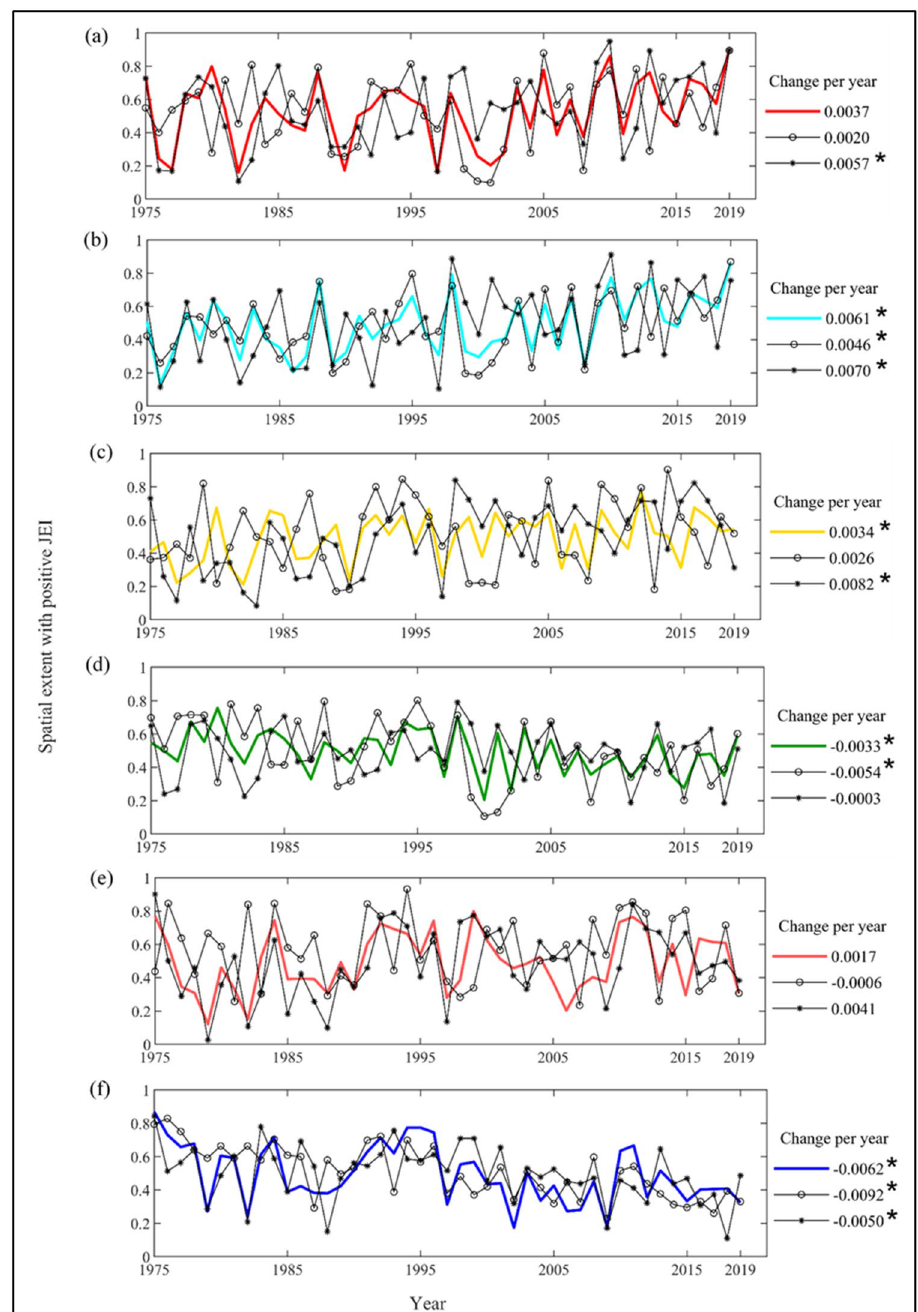
Figure 3. Year-wise variation of areal coverage (in proportion of entire Indian mainland) exhibiting positive Joint Extreme Indices (JEIs) during the post-climate regime shift period, i.e. 1975–2019 for three cases considering entire year (shown in solid shaded lines), monsoon season (shown in black lines with circle markers) and non-monsoon season (shown in black lines with star markers): ( a ) HWD, ( b ) HNWD, ( c ) WDS, ( d ) WWS, ( e ) CDS and ( f ) CWS. Rate of changes are shown in the legend of the respective JEI and the significant rate of change are noted with star markers as per Mann–Kendall trend test at 5%